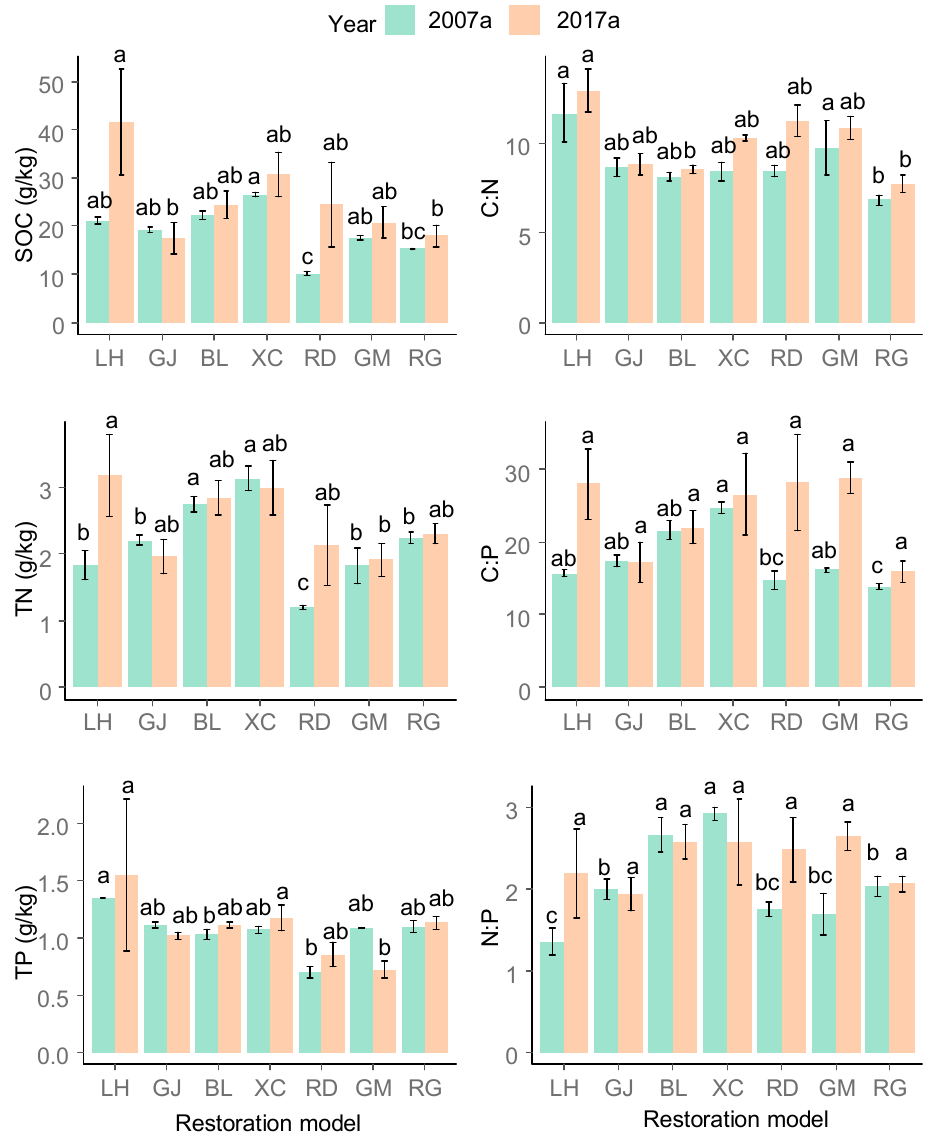
(Table 1). In the GJ model, the SOC, TN, TP, C:P, and N:P decreased. The TN and N:P in the XC model and the N:P ratio in the BL model decreased, and the indices in the other models increased. However, only the TN in the LH model, the C:N in the XC and RD models, and the C:P and the N:P ratios in the GM model showed significant changes with restoration years (Figure 1).